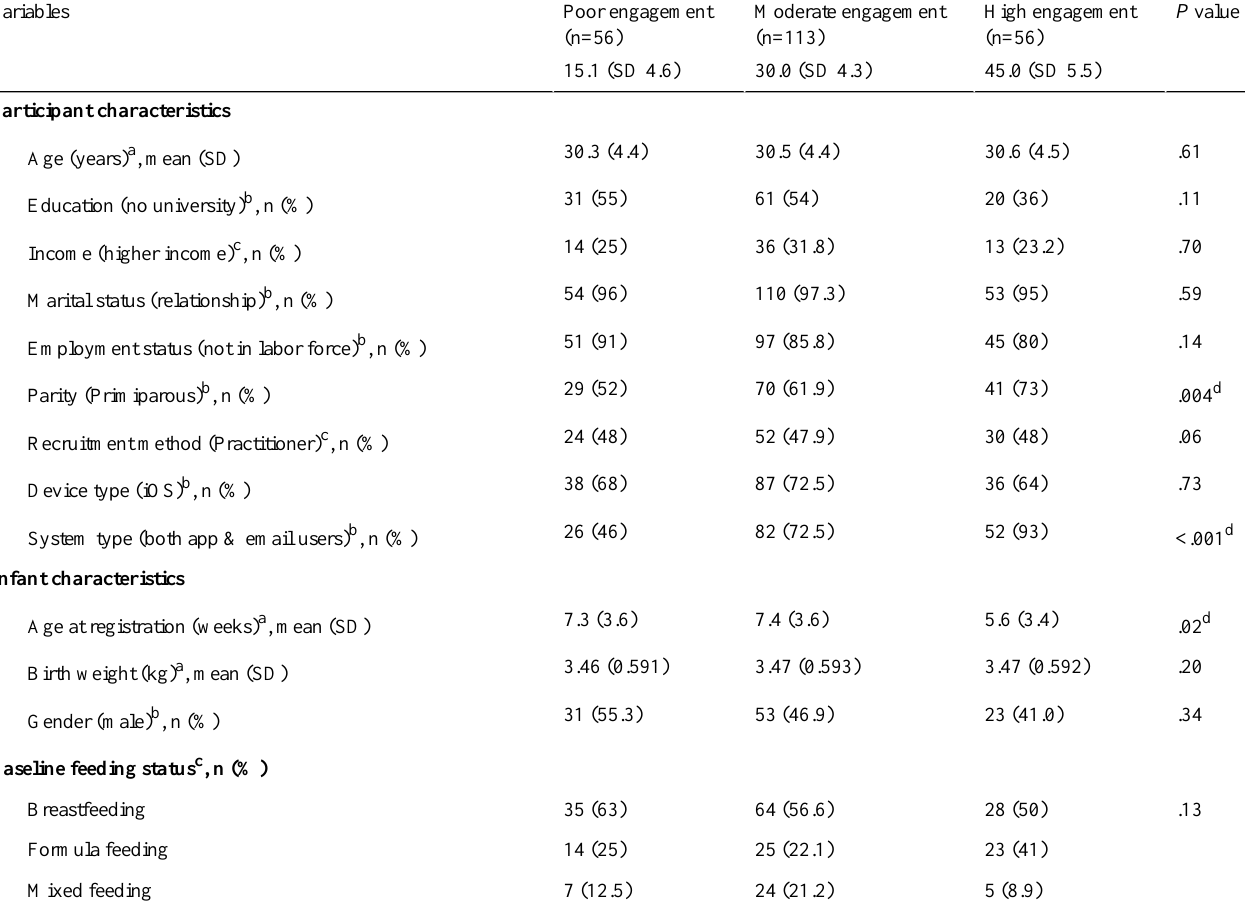
Table 1. Characteristics of growing healthy participants based on engagement index level